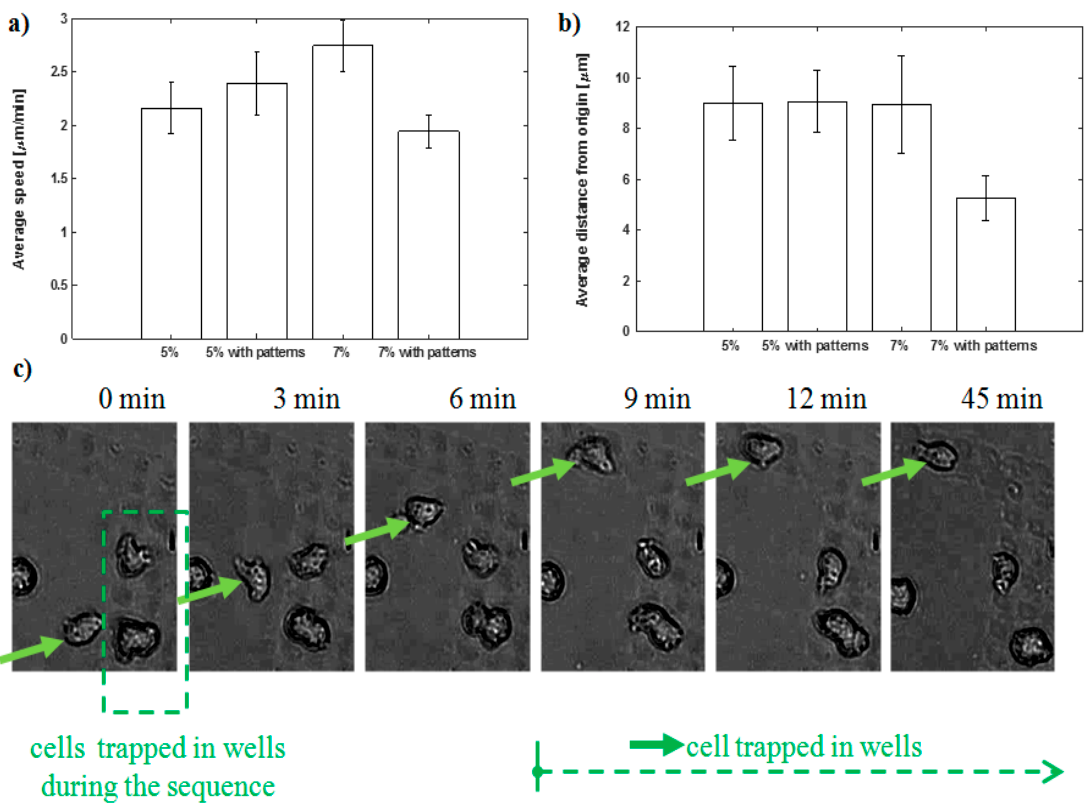
Figure 4. Influence of gel patterning and stiffness on amoeboid cell behavior: ( a ) Average cell speed; ( b ) average distance travelled by the cells from the origin to their final position during an experiment of 45 min; ( c ) representative sequence of images showing the movement and trapping of one cell in the wells of the gel.